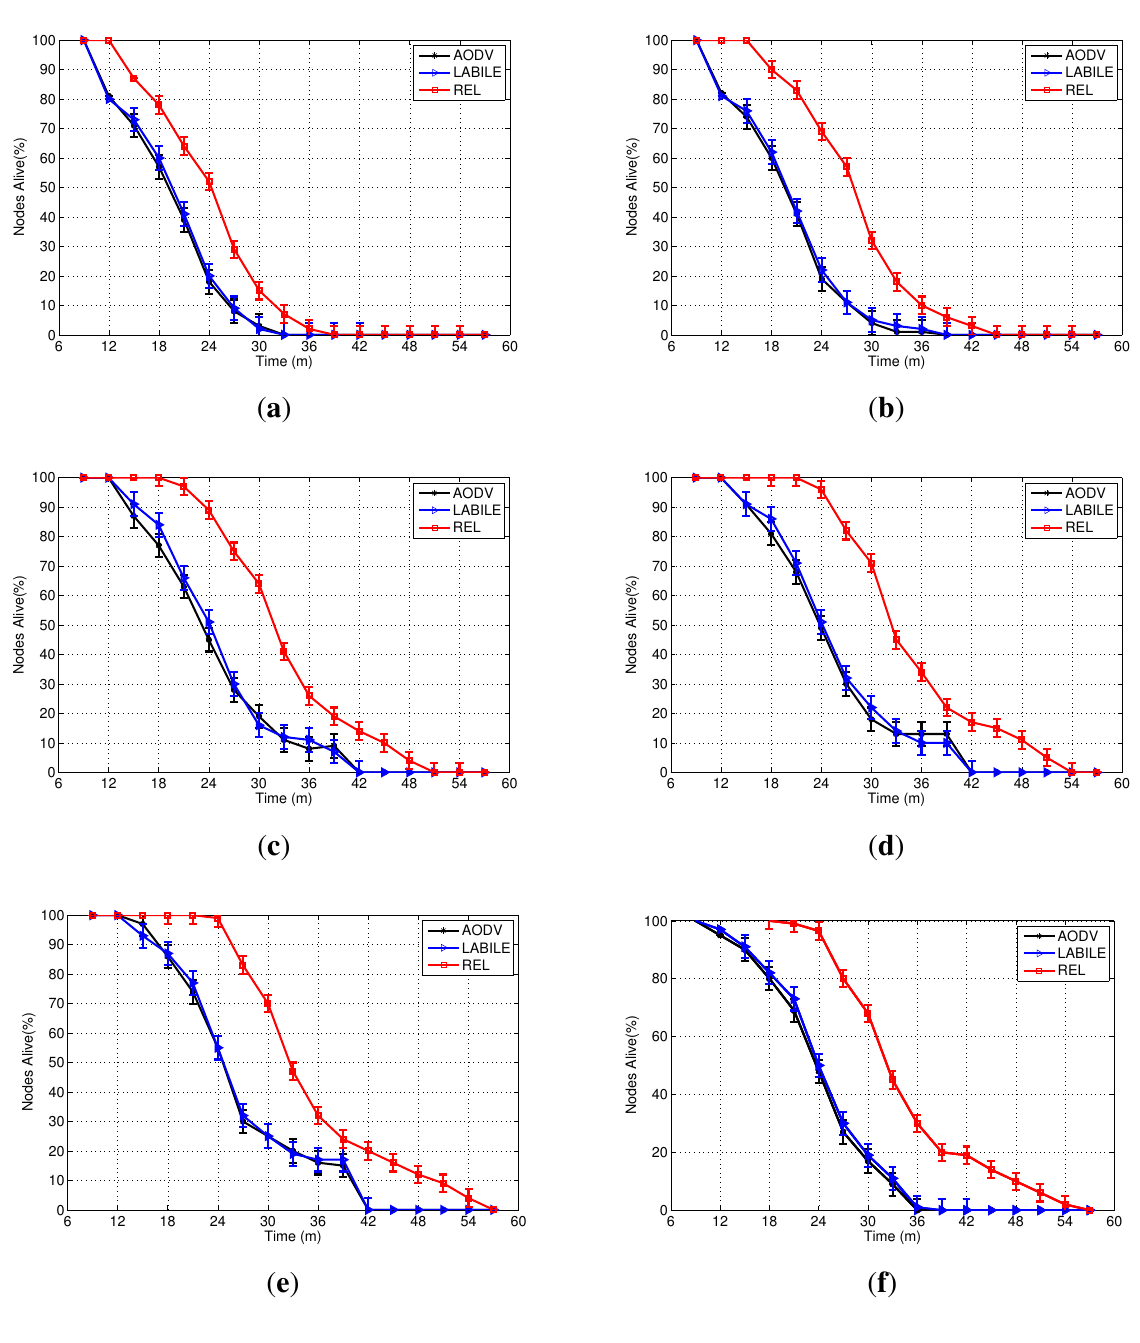
Figure 10. Network lifetime in simulation experiments. ( a ) 20 Nodes, ( b ) 40 Nodes, ( c ) 60 Nodes, ( d ) 80 Nodes, ( e ) 100 Nodes, ( f ) 200